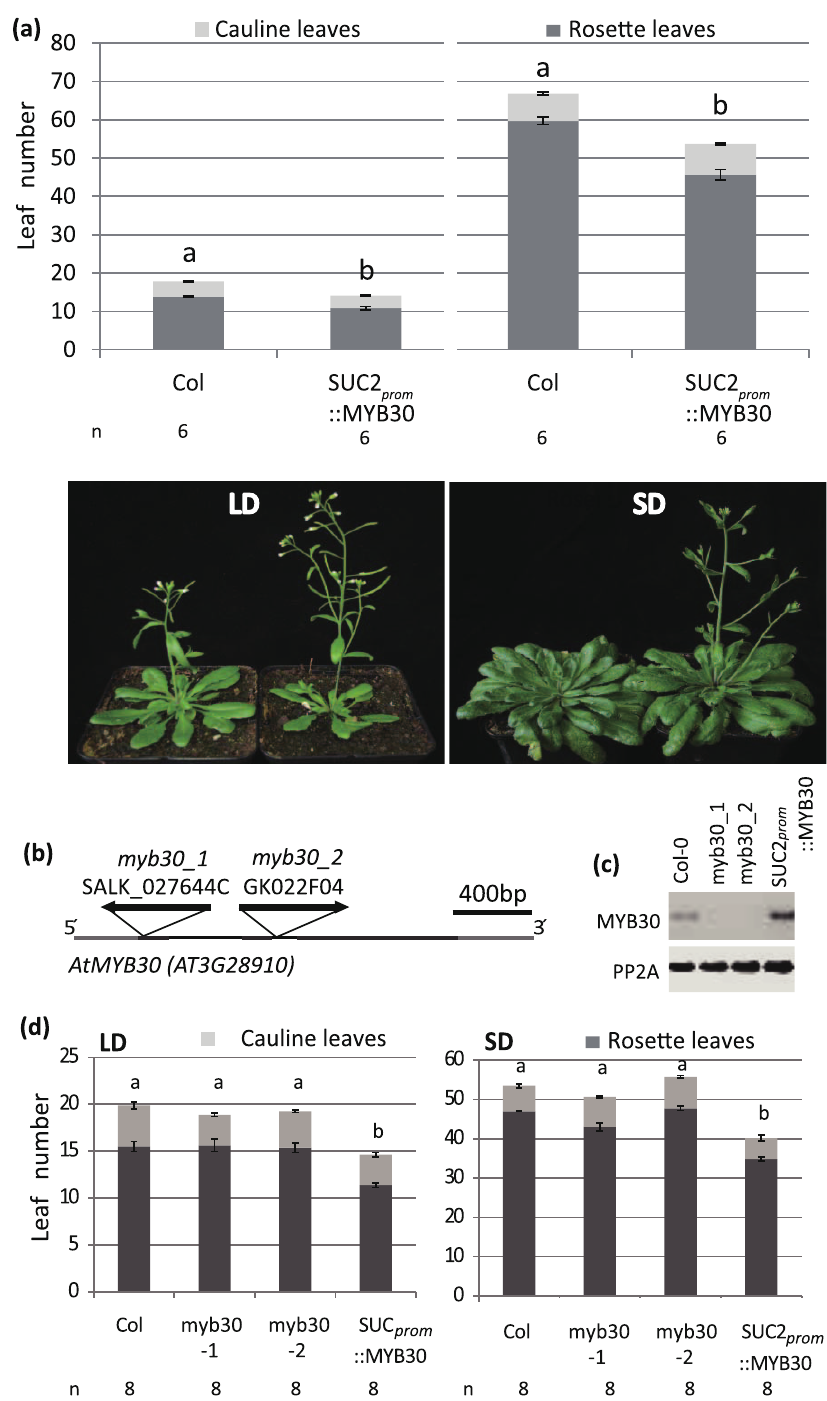
Figure 1. Flowering time of SUC2 prom ::MYB30 and myb30 mutant plants in LD and SD conditions. ( a )WT and SUC2 prom ::MYB30 expressing Col plants were grown in LDs (16 h light) and SDs (8 h light) in a temperature controlled climate chamber. The number of rosette and cauline leaves was counted to determine flowering time. Pictures were taken after the WT plants had started to bolt in each condition. Statistical significance was determined using the Student’s t-test (p , 0.01). Significant differences are indicated by different letters above the bars, SD and LD treatments are tested as separate experiments. ( b ) Position of T-DNA insertion lines of myb30 . A 400 bp PCR fragment used to detect expression is indicated. ( c ) Semi-quantitative RT-PCR confirms myb30 mutants as loss-of function alleles. ( d ) Flowering time of Col, myb30_1 , myb30_2 and SUC2 prom ::MYB30 plants were measured in LD (left) and SD (right) conditions in a temperature controlled climate chamber. Statistical significance was determined using the Student’s t-test by comparing each genotype to the respective Col control (p , 0.01). Significant differences are indicated by different letters above the bars. The number of plants for each genotype (n) is indicated below the graph.